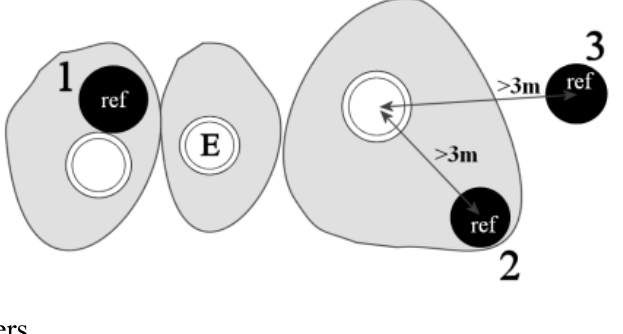
Figure 3. Comparison of reference (black dots) and modeled (white dots) trees, with the model crown delineation shown as a grey area. Reference tree #1 is classified as a match, reference tree #2 as missed but within the crown area, and reference tree #3 as missed and outside crown area (omission error). The extra tree (commission error) in the model is marked by the letter